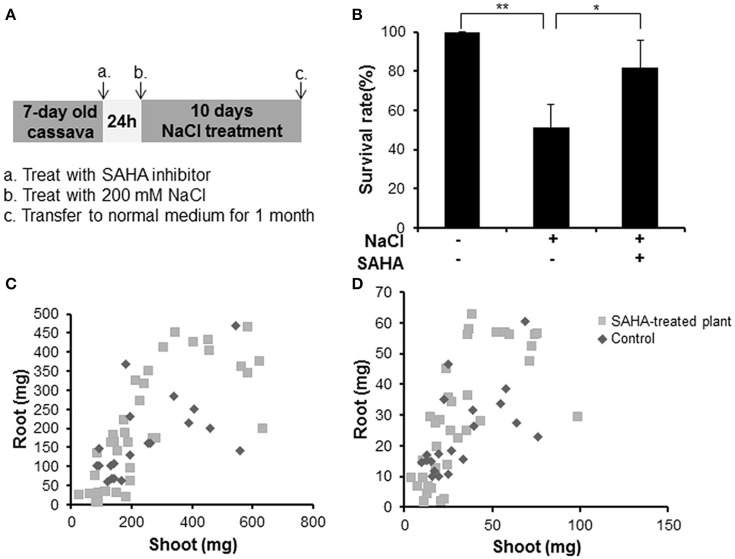
Increase in survival rate and plant weight by SAHA treatment under high salinity stress conditions in cassava. (A) Experimental condition. Cassava plantlets were treated with 100 μM SAHA for 24 h then subjected to 200 mM NaCl medium for 10 days. The survival rate was counted after transferring cassava to normal medium for 1 month. (B) Survival rate under high salinity stress of non-treated plants and SAHA-treated plants. Three independent experiments were performed (at least 13 plants per experiment). (C,D) Comparison of plant fresh weight (C) and dry weight (D) between non-treated plants and SAHA-treated plants. Asterisks indicate significantly different means (*p < 0.05, **p < 0.005) as determined with a t-test. Error bars represent the mean ± SD.